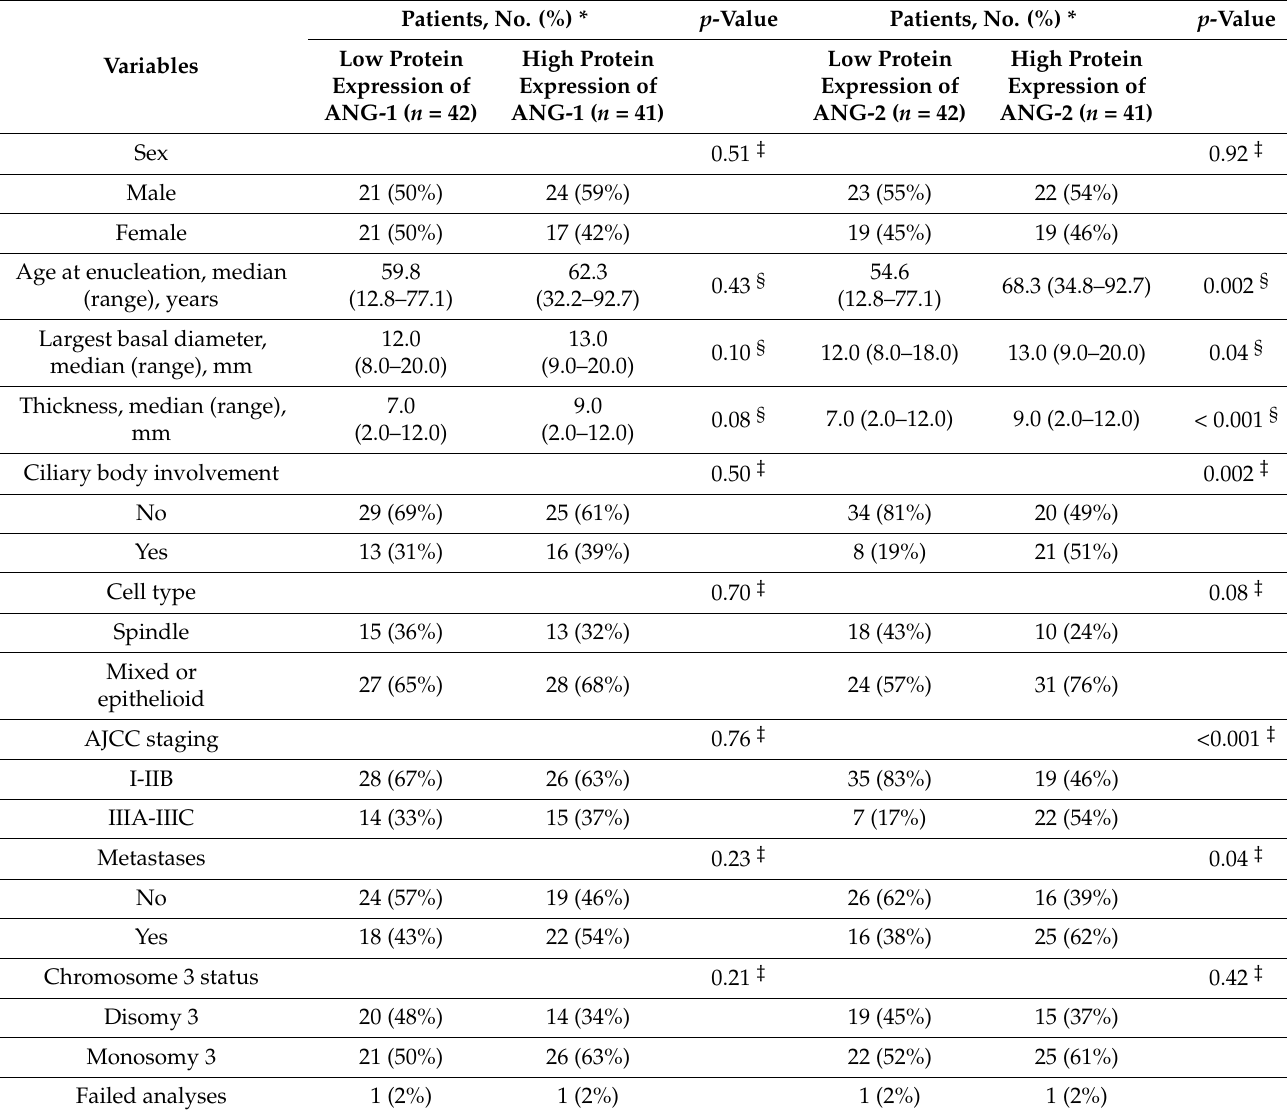
Table 2. Comparison of clinical, histopathological, and genetic characteristics of UM with a low or high protein expression of ANG-1 and ANG-2 in the aqueous. The groups were separated according to the